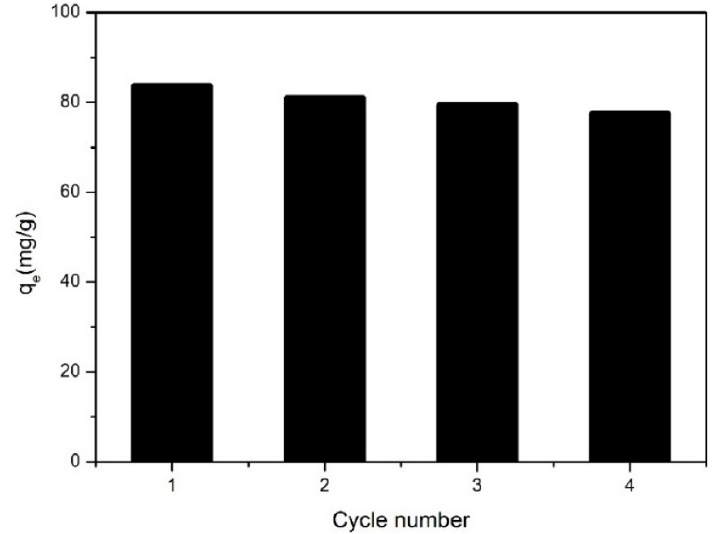
Figure 9. Variation in adsorption of Cu(II) in cycles of regeneration from IDA-OAC.